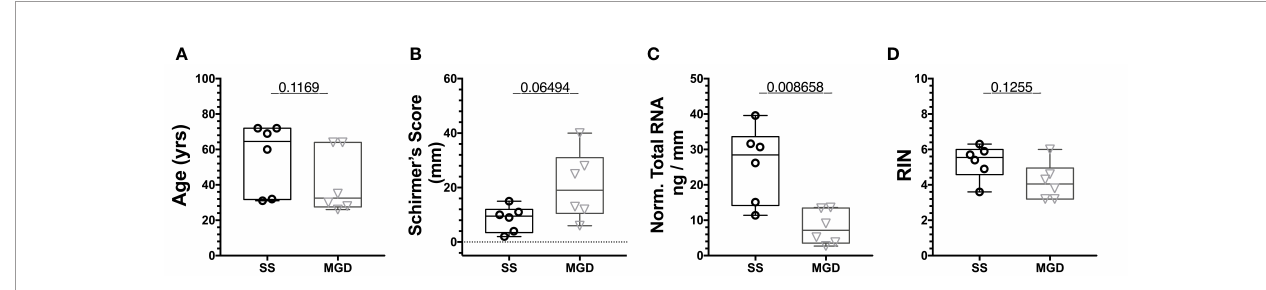
FIGURE 6 | Quality assessment of RNA isolated from patients using Tapestation. (A) There was no signi fi cant difference in the age of patients from the two groups. (B) Schirmer ’ s test score was higher for SS patients than MGD patients. (C) Normalized to tear volume, SS patient tears had signi fi cantly higher amounts of total RNA than tears of MGD patients. (D) There was no signi fi cant difference in the RIN values of RNA from SS and MGD patient tears. N=6 samples each for SS and MGD patients. Samples were analyzed using a Mann-Whitney U test with p<0.05 considered signi fi cantly